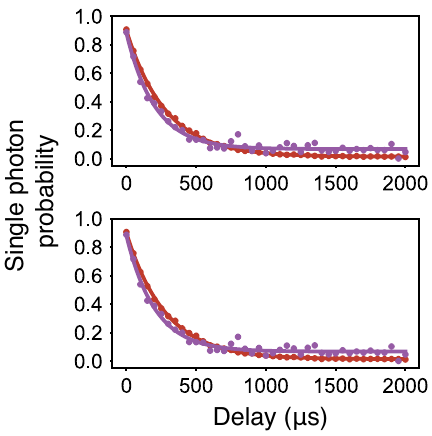
FIG. 6. Measurement of intrinsic and pump-induced decay rates. Cavity T 1 experiments with either a varying delay (red) or the application of an off-resonant squeezing operation (purple) during the delay for cavities A (top) and B (bottom).